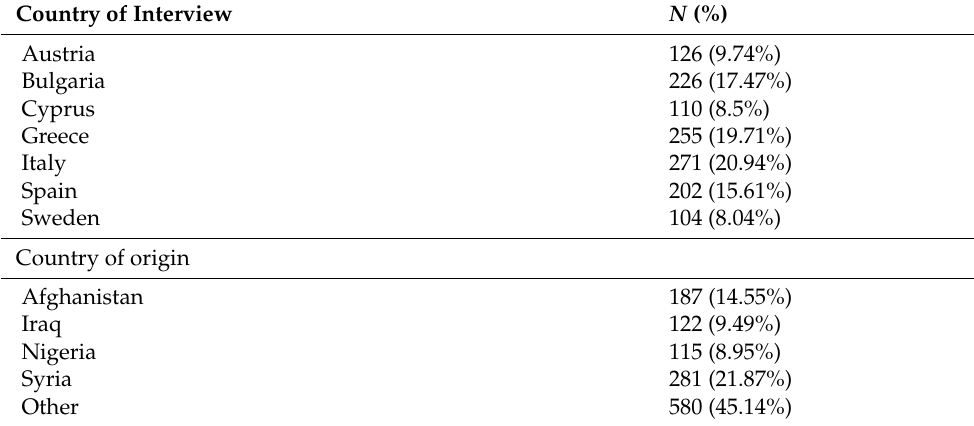
Table 1. Characteristics of migrants and refugees, except those from Germany, France and Malta ( N =